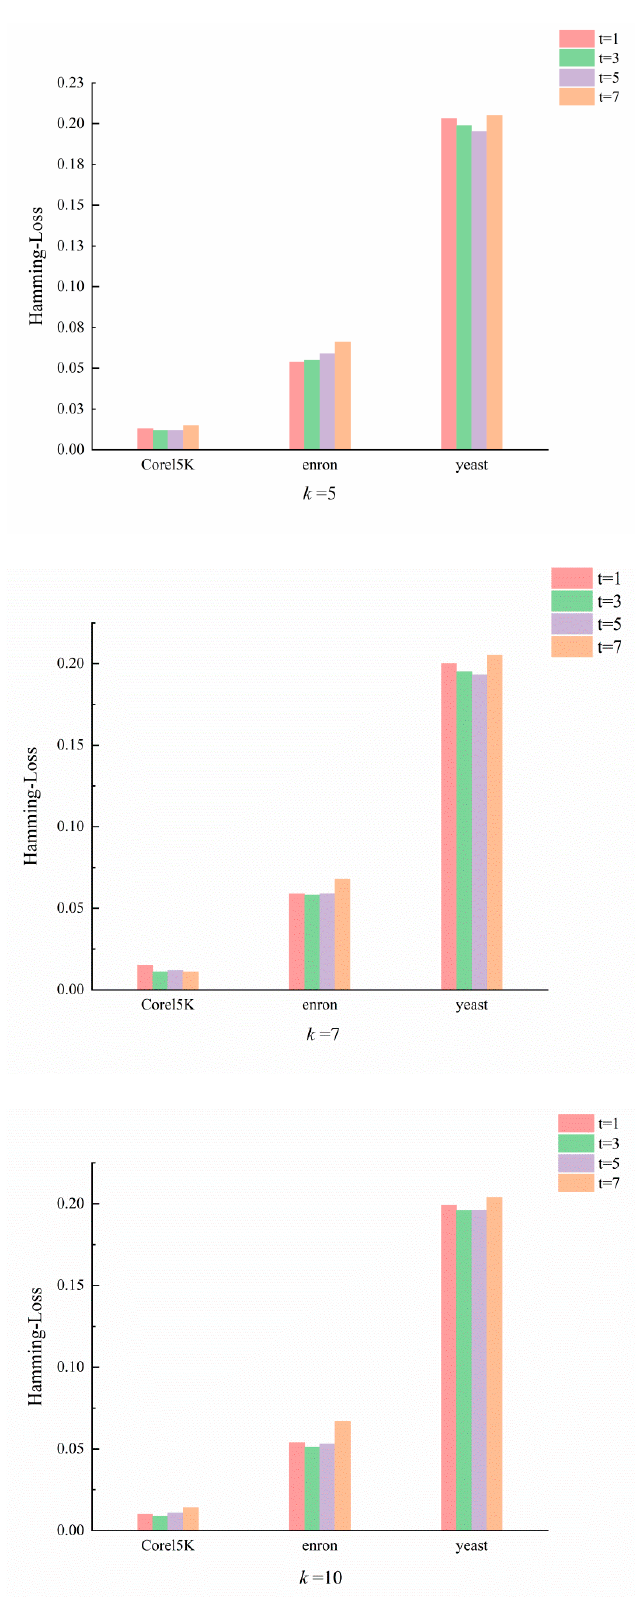
Figure 1. Hamming loss for different values of k and t in different datasets. Different colors represent different values of t .